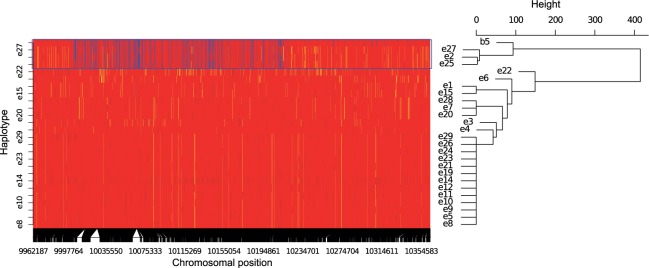
Haplotype-block 12 and the evolved haplotypes from generation 67. Haplotype-block 12 from the base population is labeled with b5; 25 evolved haplotypes are labeled with e (four evolved haplotypes were excluded as <20% of their bases in that region were called). The left panel represents the haplotype block structure. Each horizontal line corresponds to one haplotype and each column to a singleton-SNP position within the base haplotypes. SNPs specific to haplotype-block 12 are indicated in blue, yellow indicates the remaining singletons in the base population. The major allele in the base population is shown in red. Missing data are shown in gray. The right panel shows a cladogram (average linkage clustering) based on singleton-SNP sharing. The blue rectangle marks the evolved haplotypes that cluster with b5. The core of the haplotype-block is shared among the three evolved haplotypes indicating no recombination in this region. As toward the end of the blocks singleton markers for b5 are scarce, it might be that the block has been called slightly too long.